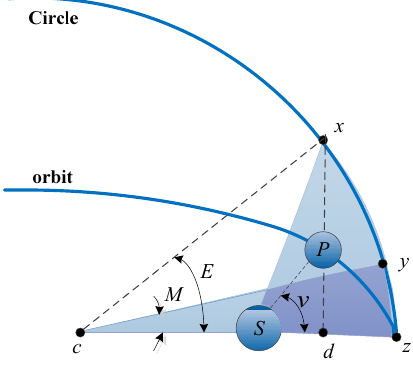
Figure 5. Geometric relationship among M , v and E .